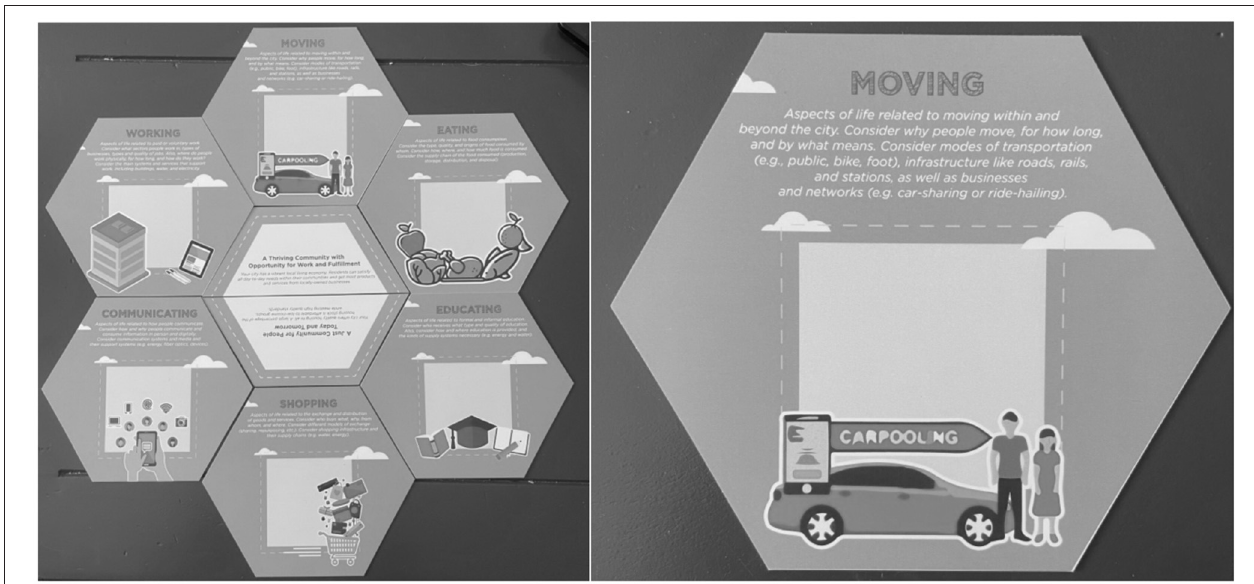
FIGURE 2 | Lifestyle cards surrounding two transformative sustainability goal cards (left) and a close up of the moving card (right)